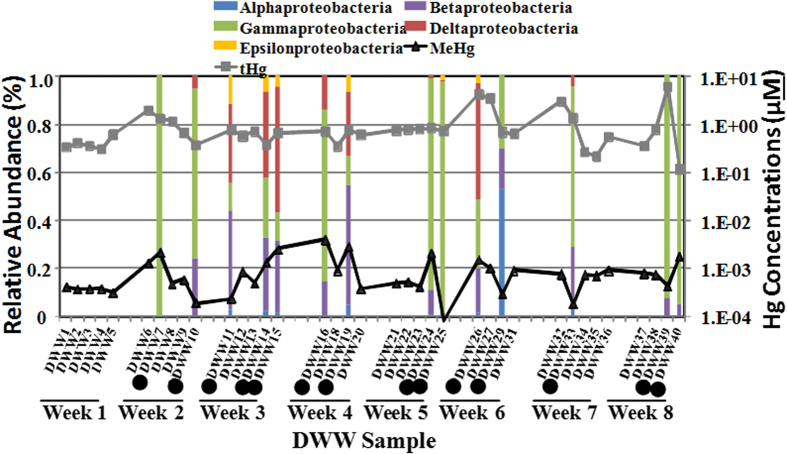
Relationship between proteobacterial diversity and tHg and MeHg over time in DWW samples (DWW1-DWW40) collected from the 12-chair dental clinic.Primary vertical axis reflects the variations in relative abundance of Proteobacteria diversity, and the secondary vertical axis shows the variation in tHg and MeHg concentration during the 8 week sample collection period. (•) Represents samples further selected for pyrosequencing. MeHg at DWW25 (8.1E-5 μM) is not shown for clarity.